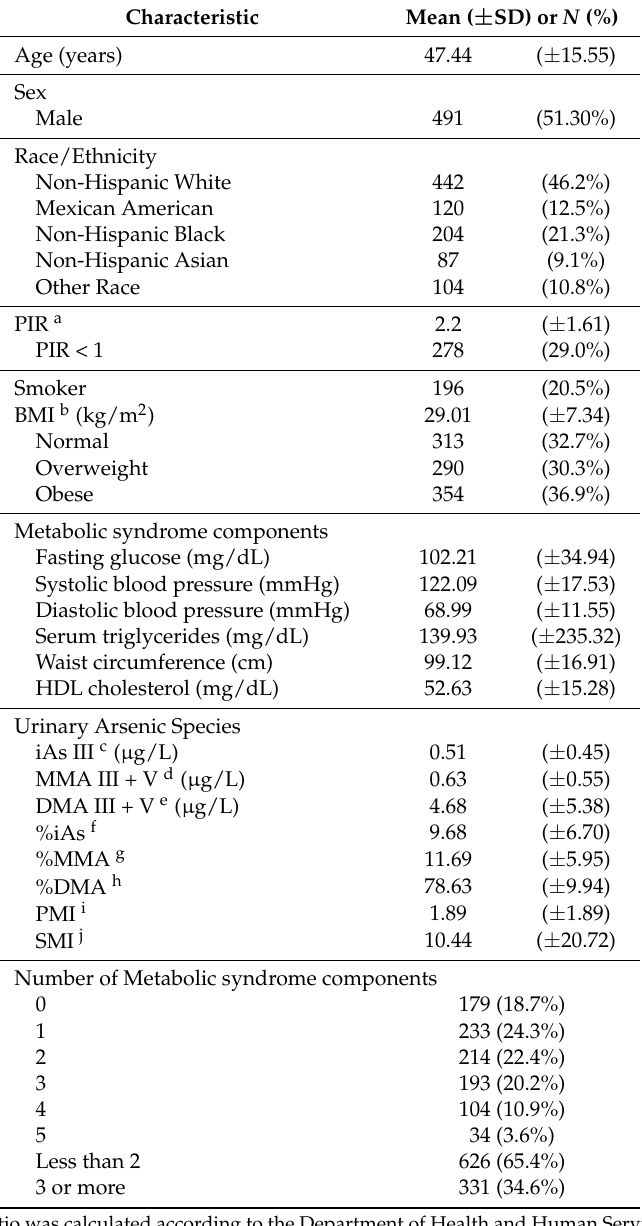
Table 1. Study participant